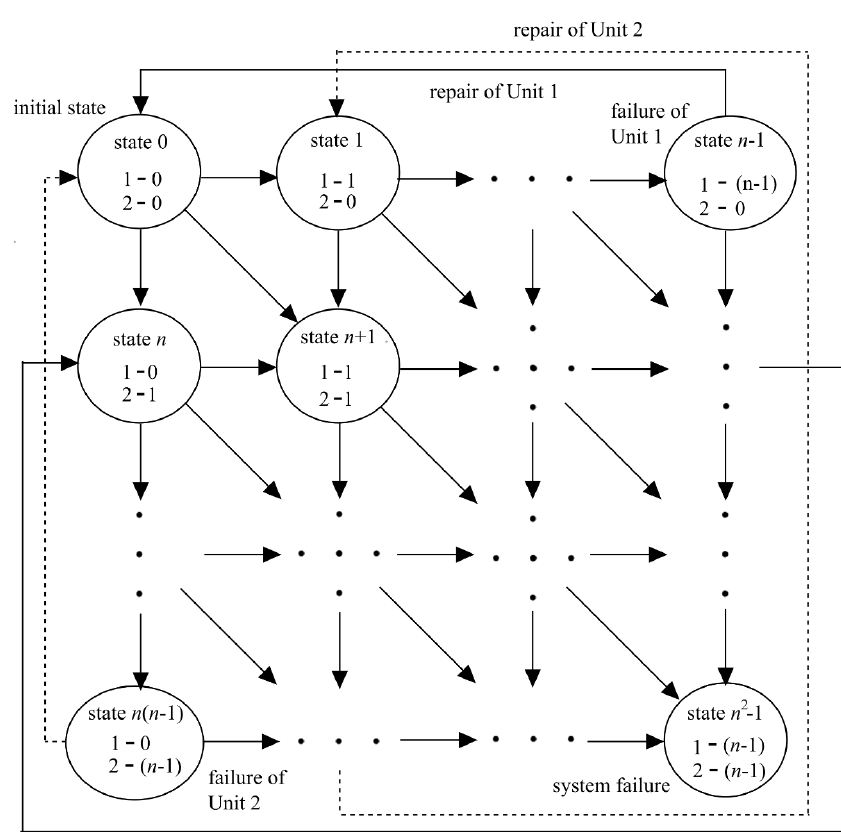
Figure 1. Configuration of the two-unit parallel redundant system with deterioration on 𝑛 × 𝑛